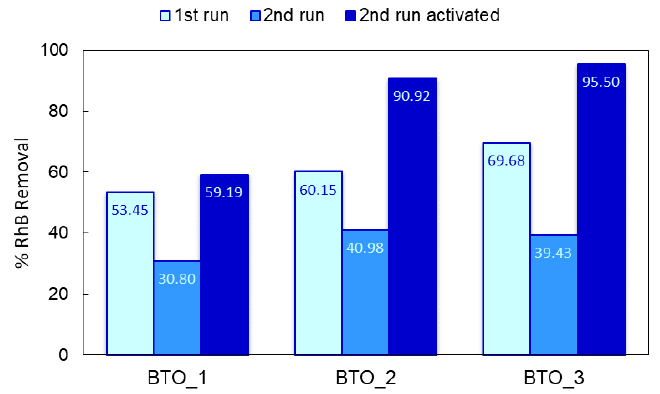
tical applications.